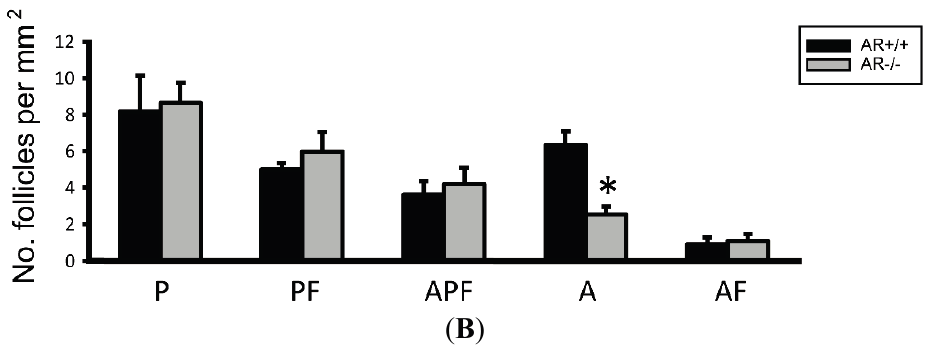
Figure 3. Morphological changes of ovarian follicle in AR − / − mice. ( A ) Comparison of morphology in ovaries of 4.5-week-old AR +/+ and AR − / − female mice after PMSG-priming for 48 h ( n = 4 mice per genotype). Representative hematoxylin and eosin-stained ovarian sections ( a : AR +/+ , b , c : AR +/+ , d : AR − / − at 100× magnification; e , f : AR − / − at